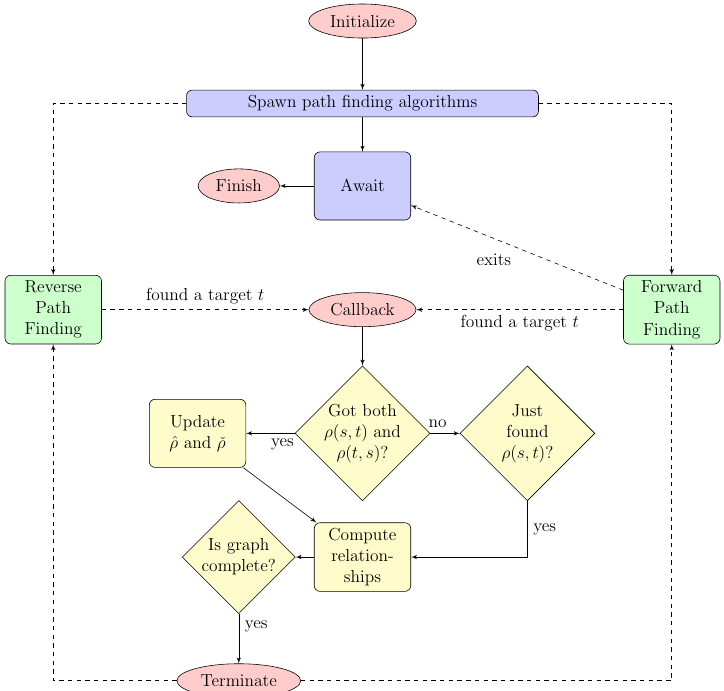
Figure 4. Flowchart of our asynchronous algorithm determining the ranks of the target vertices. The flowchart shows asynchronous (dashed arrows) and synchronous (solid arrows) execution of tasks (rounded rectangles). Tasks of different threads are grouped by color: The main thread is blue, both shortest-path-finding threads are colored in green and the callback thread is